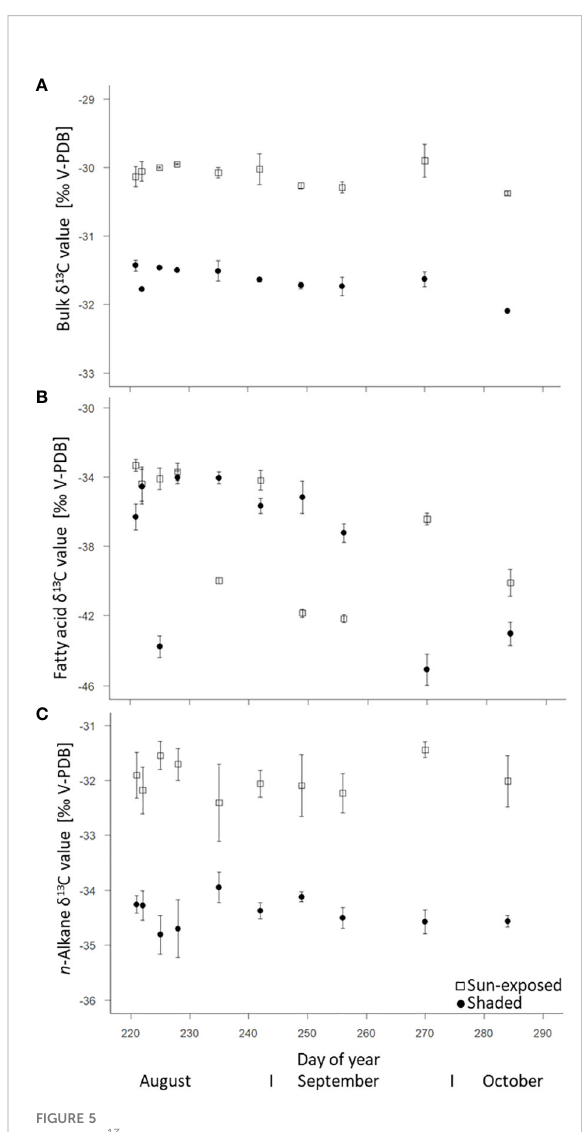
FIGURE 5 Natural d 13 C abundance (control spot) of bulk tissue (A) , fatty acids (intracuticular waxes) (B) , and n -alkanes (cuticular waxes) (C) of sun-exposed and shaded leaves (analytical replicates n=3, error bars indicate SE).